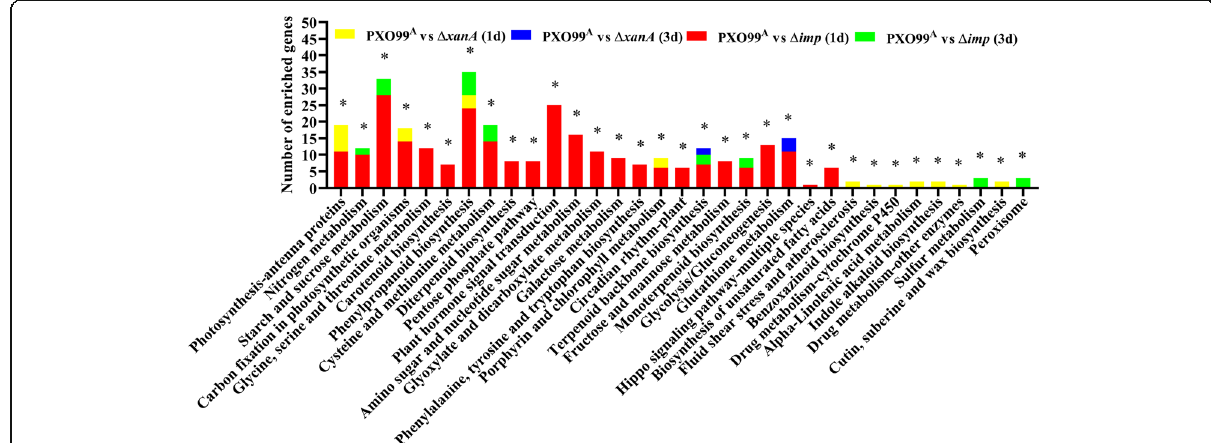
Fig. 5 KEGG pathway enrichment analysis of DEGs from comparison groups PXO99 A vs Δ xanA (1d), PXO99 A vs Δ xanA (3d), PXO99 A vs Δ imp (1d) and PXO99 A vs Δ imp (3d). Histogram of the top 33 significantly enriched pathways with the highest representation of the DEGs. The names of the KEGG pathways are listed along the x-axis. The y-axis indicates the number of enriched genes in different comparison groups. Asterisks indicate significant enrichment (* P < 0.05). The detailed information is shown in Table